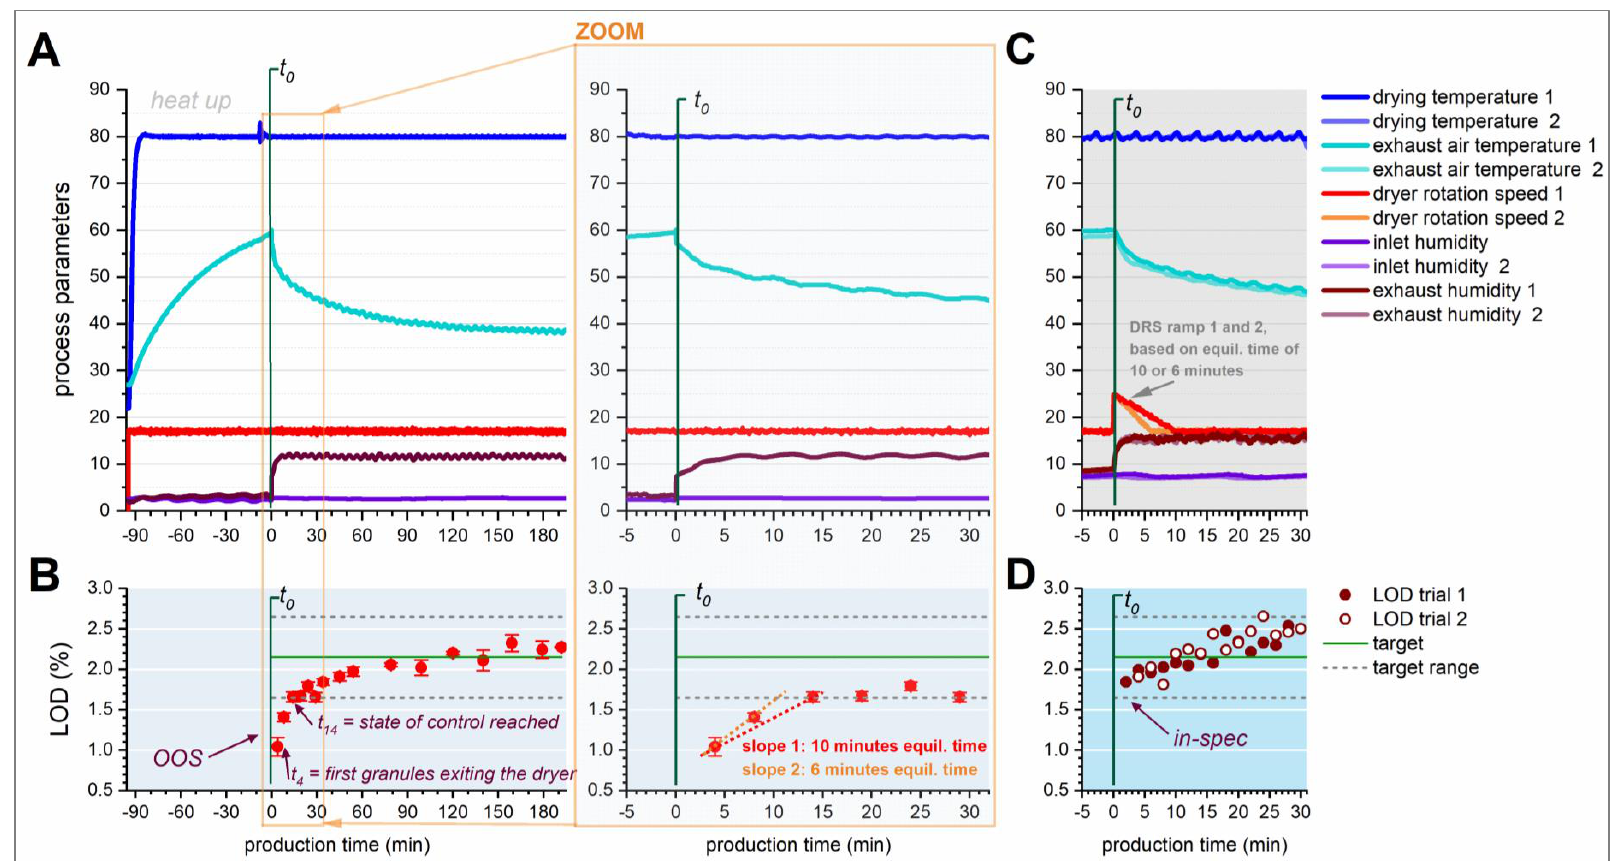
Figure 3. ( A ) Process dynamics in the continuous fluid-bed dryer during heat up and after starting the drying process at t 0 . The right side of A shows a zoom-in sections of the left graph. ( B ) LOD-dynamics during process start-up after 1.5 h of FBD pre-heating ( t 0 = start of granulation). Acceptance limits are defined as dry-blend LOD (=target LOD) ± 0.5%. ( C ) Process dynamics in the continuous fluid-bed dryer after starting the drying process with the model-based DRS start-up procedure. ( D ) LOD-dynamics during process start-up with DRS start-up-procedure; LOD is found within its acceptance range from the very beginning. Figure adapted from [29].